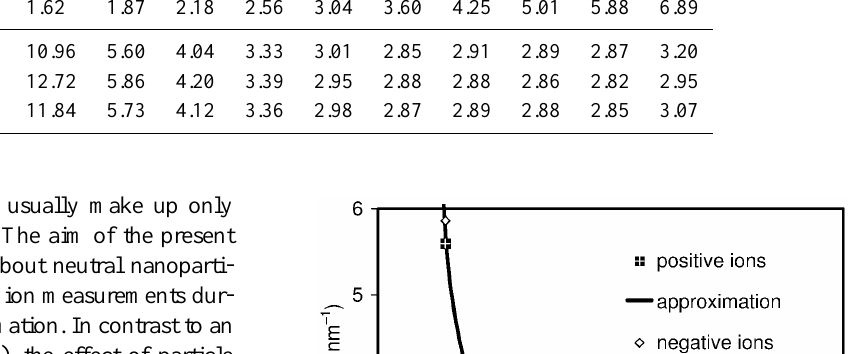
Table 1. Near-median size distribution of intermediate ions in Tartu, Estonia, according to Tammet et al. (2012). The upper index indicates the polarity of ions while n 1 (d) without the upper index denotes the mean of positive and negative ions. d ,nm